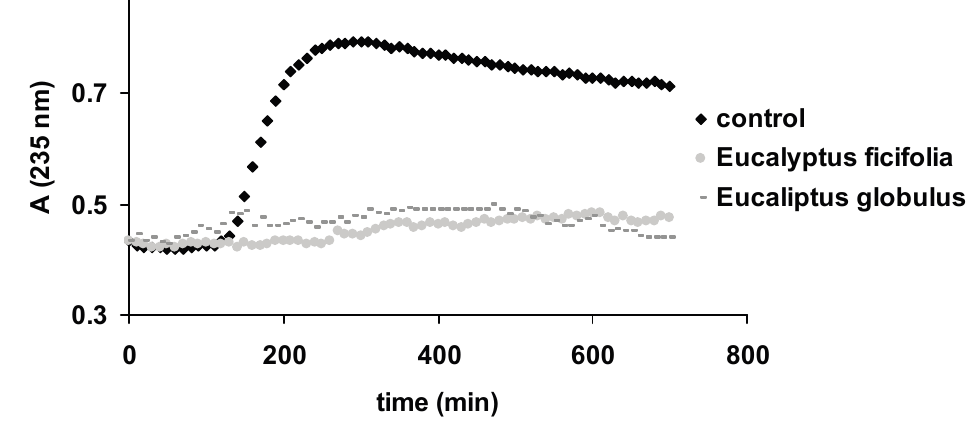
Figure 1. Liposome oxidation by cytochrome c , in the presence of the tested samples.